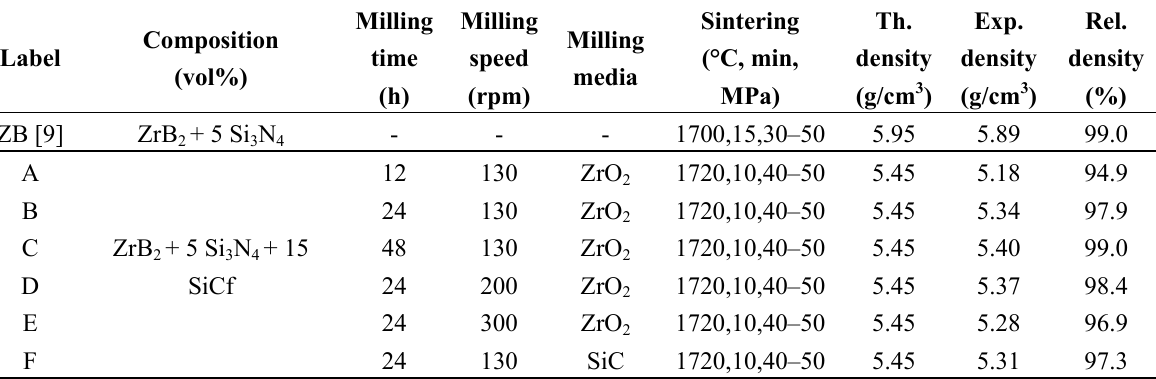
Table 1. List of the samples: label, composition, milling time, milling speed, milling media , dwell time, pressure) and densities (theoretical, type, sintering conditions (T MAX experimental,